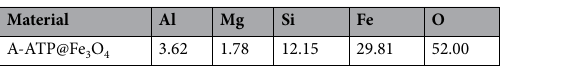
Table 1. The atomic content of corresponding elemental of A-ATP@Fe 3 O 4 (%).